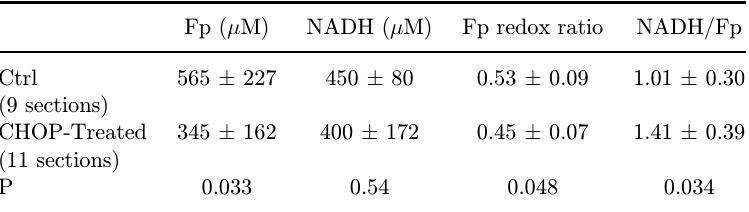
Table 2. Mean values of the redox indices (cid:3) SD.